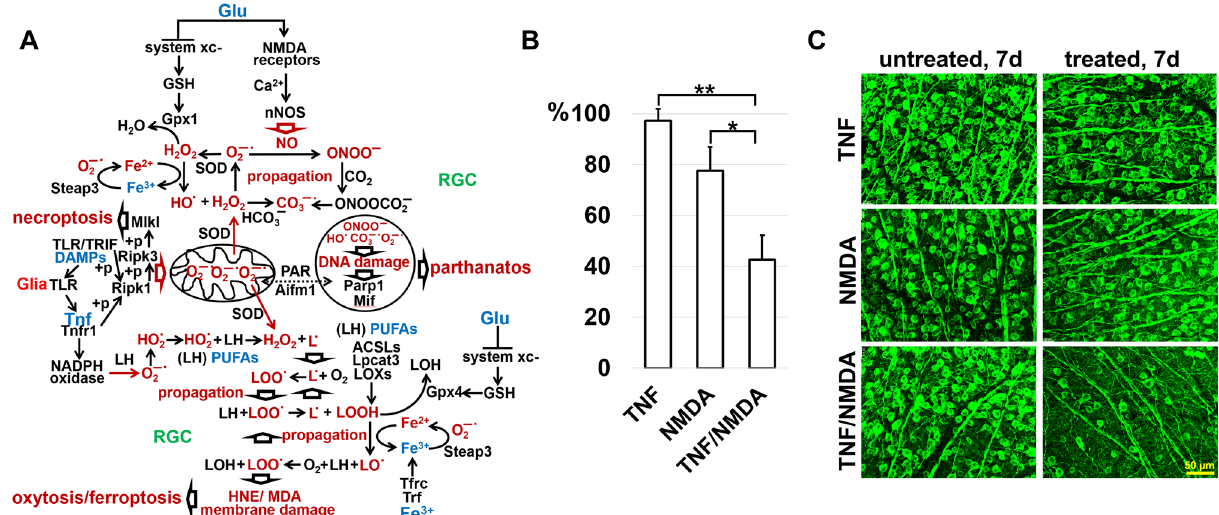
Figure 7. Three compounds, Tnf, glutamate, and iron, present at high concentrations in the IR retina, are likely to promote at least necroptosis, oxytosis/ferroptosis, and parthanatos, leading to significant RGC death. ( A ) The necroptosis, oxytosis/ferroptosis, and parthanatos signaling cascades are interconnected with each other and, in the presence of Tnf, glutamate, and iron, they can be started simultaneously with high efficiency. ( B , C )